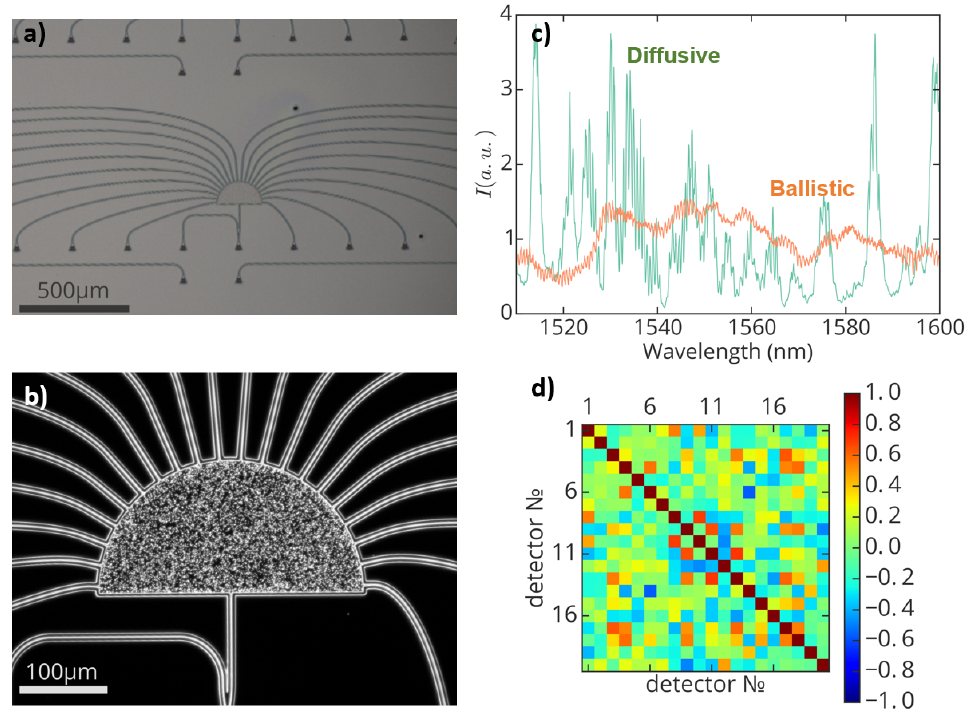
Figure 2. ( a ) Bright-field image of the integrated random spectrometer ( b ) Dark-field image of integrated random spectrometer ( c ) Response signal on detectors operating in the diffusive and ballistic regimes. The orange color for the transmission spectrum represents the ballistic regime of propagation for optical radiation and the green color represents the diffusive regime. ( d ) Correlation matrix for a spectrometer, which does not account for the poorly calibrated